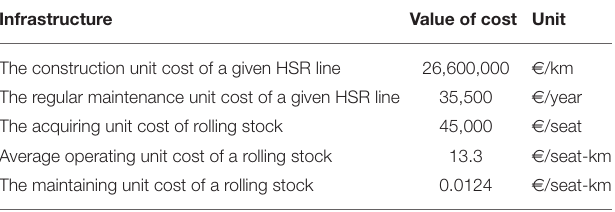
TABLE 7 | Characteristics of the HSR costs in 2017 prices. TABLE 8 | Average access time to get to HSR stations in Madrid and Barcelona by different